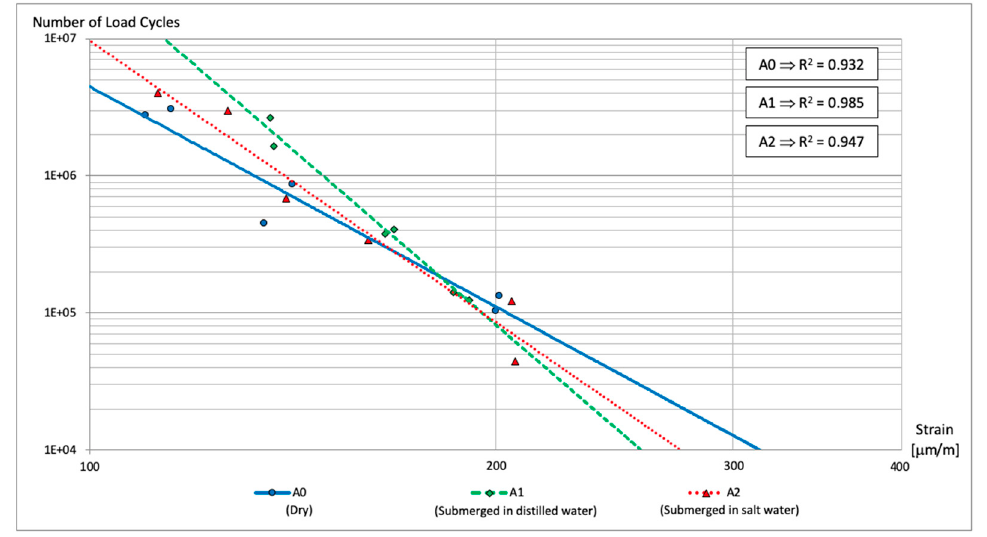
Figure 4. Fatigue test: specimens at constant temperature of 20 °C.